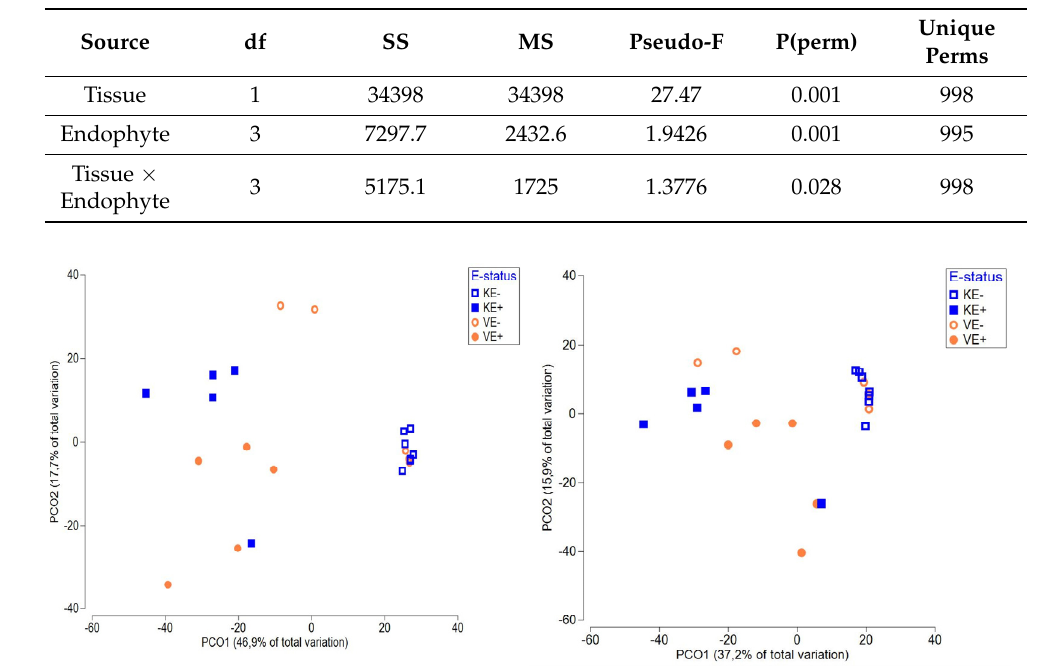
Table 2. PERMANOVA results for Epichloë-depleted fungal communities in meadow fescue.